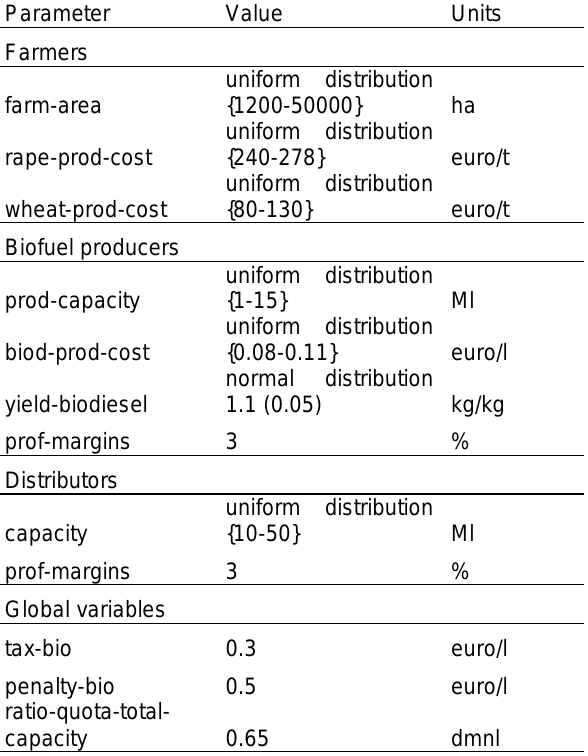
Table A.1. Parameters of the agents used in the initialization of the simulation